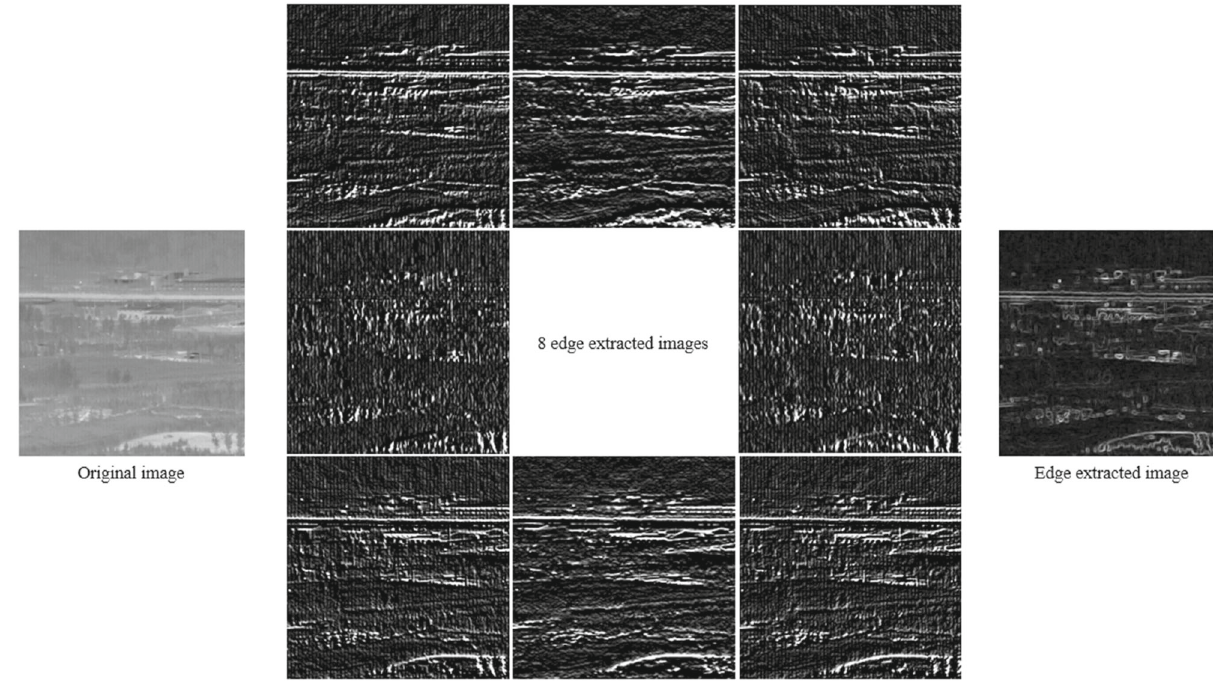
Fig. 2 The result of applying Kirsch kernels to an image